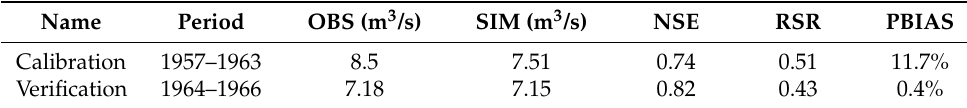
Table 3. The calibration and verification of SWAT model.